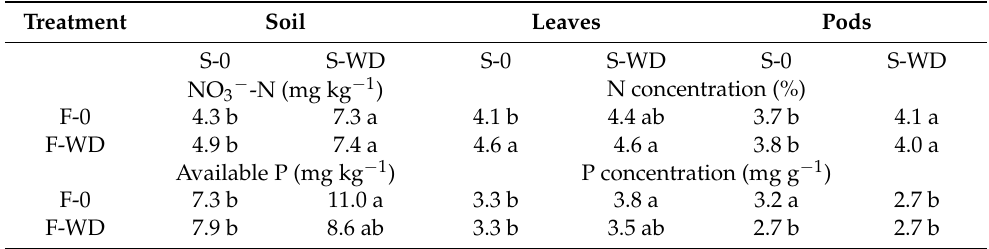
Table 5. Nitrogen and phosphorus concentration in the soil and in the leaves and pods of field bean, as affected by the interaction of wood distillate (WD) distribution as foliar spray (F) and soil irrigation (S). Data are means of three replicates. For each parameter, means followed by the same letter are not significantly different at p ≤ 0.05, Tukey